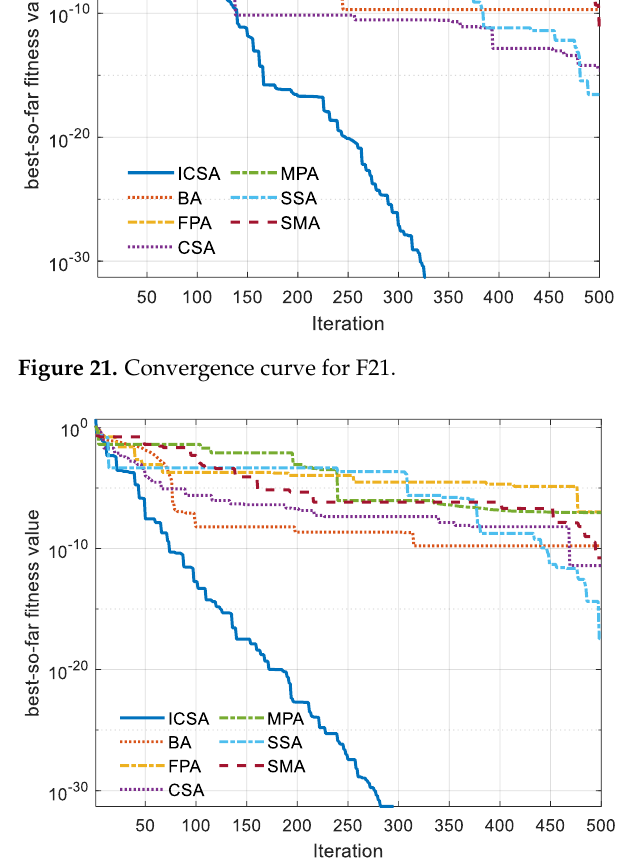
Figure 22. Convergence curve for F28.